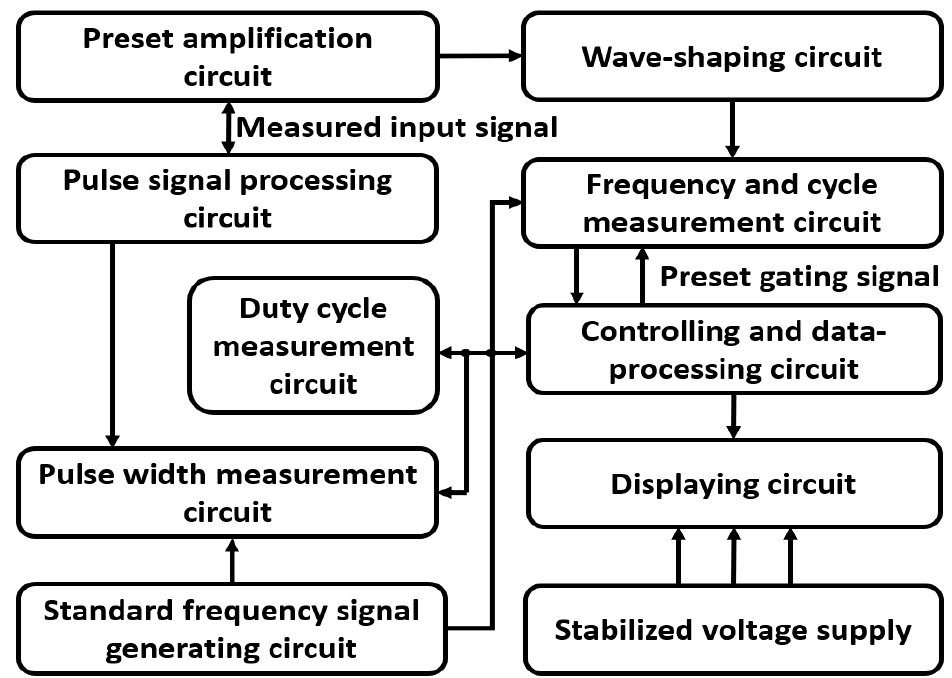
Figure 1. Structure diagram of the equal precision digital cymometer.